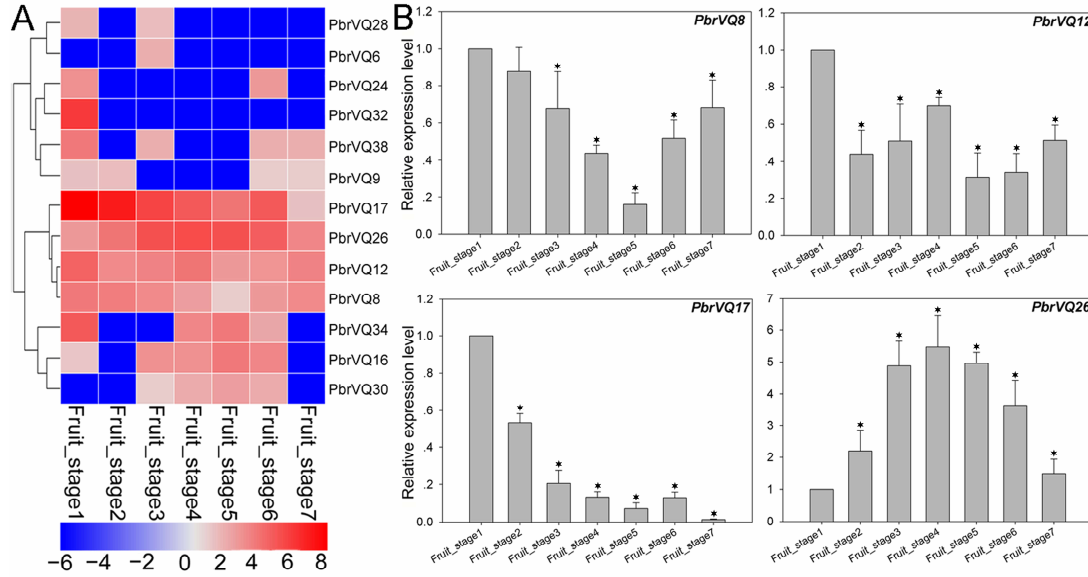
Figure 5. Expression profiles of P. bretschneideri VQ motif-containing genes during seven fruit developmental stages, including fruit_stage1 (15 days after full blooming (DAB)), fruit_stage2 (30 DAB), fruit_stage3 (55 DAB), fruit_stage4 (85 DAB), fruit_stage5 (115 DAB), fruit_stage6 (mature stage), and fruit_stage7 (fruit senescence stage). ( A ) Heat map showing expression levels of 13 P. bretschneideri VQ motif-containing genes in seven stages of pear fruit development. As shown in the bar at the left bottom of Figure 5, gene transcript abundance is represent by different colors in the map. The FPKM (Fragments Per Kilobase of exon model per Million mapped fragments) values of PbVQ genes are presented in Table S5. ( B ) Gene expression of PbrVQ8 , PbrVQ12 , PbrVQ17, and PbrVQ26 was analyzed by real-time polymerase chain reaction (qRT-PCR). The standard error bar indicates three biological replicates. The asterisk indicates the significant difference (* p < 0.05) between treatment and control (fruit_stage1).